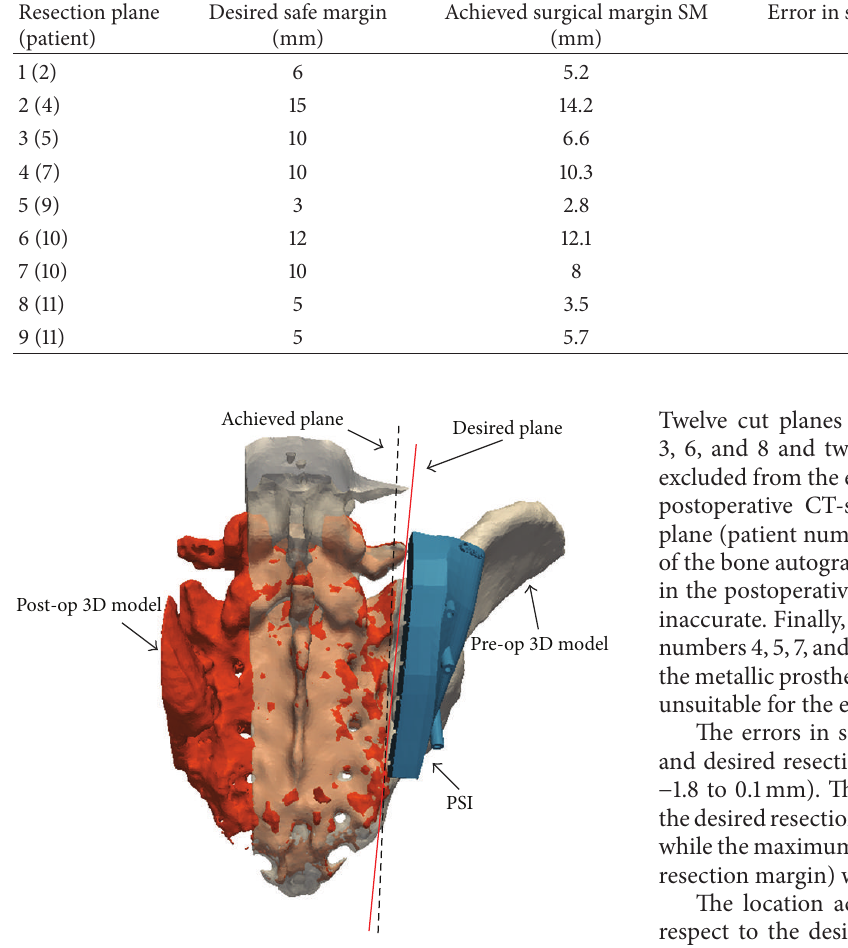
Figure 4: Quantitative evaluation of bone cuts for patient number 2. Postoperative 3D virtual model of the patient was constructed from the postoperative CT images and registered to the preoperative 3D model. The achieved cut plane was manually identified and com- paredtothedesiredcutplane.Seetextfordetailsonthecomputation of location accuracy parameter L and surgical margin